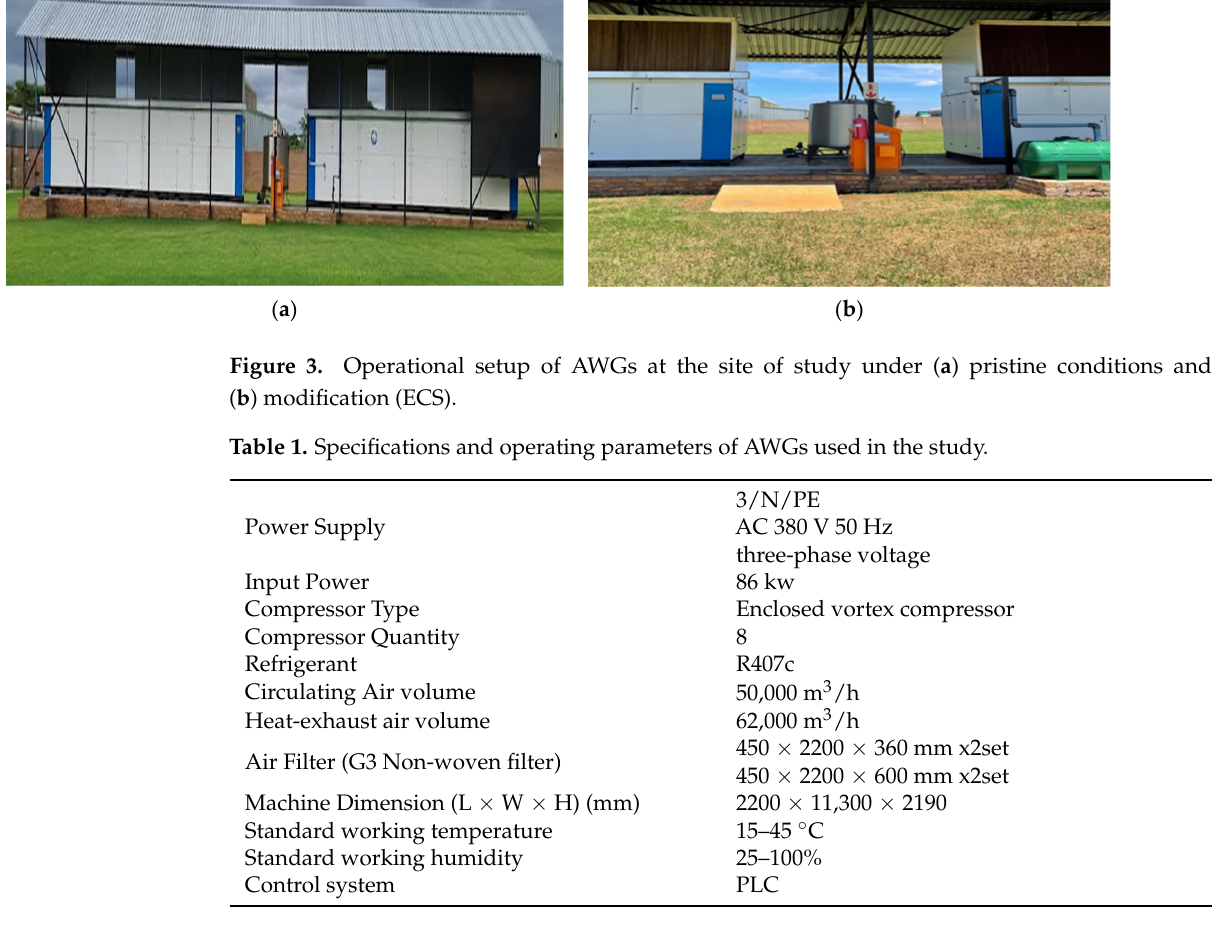
Figure 3. Operational setup of AWGs at the site of study under ( a ) pristine conditions and ( b ) mod- ification (ECS).